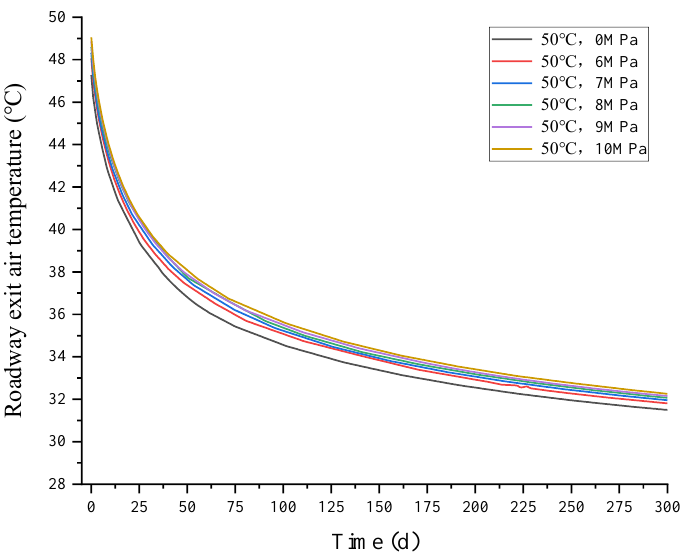
Figure 15. The airflow temperature in the outlet of the roadway at different pressures and the same temperature.